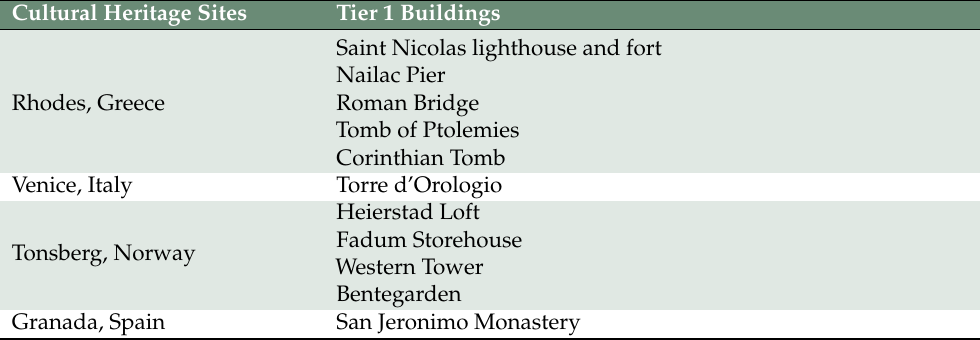
Table 1. Cultural heritage sites and Tier 1 building under